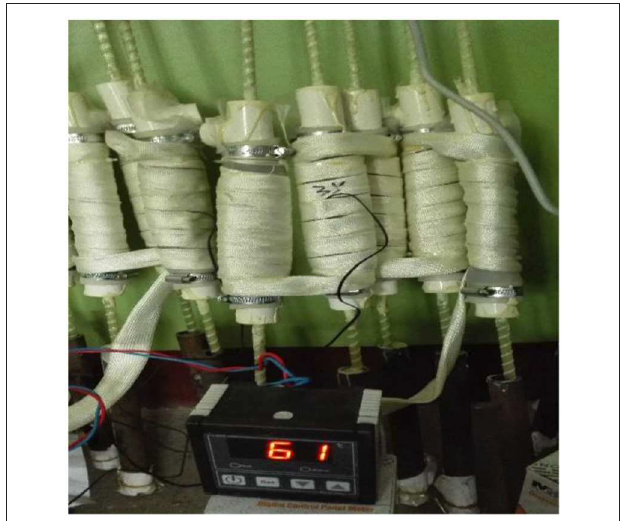
FIGURE 3 | Heating measures for specimens.